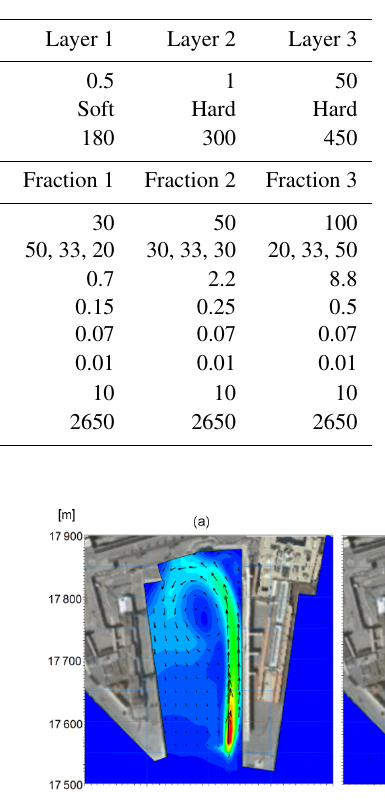
Table 3. Summary of sediment characteristics as implemented in the mud transport model.